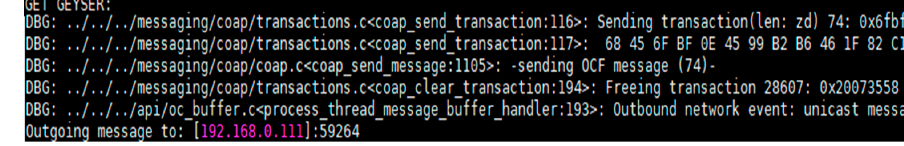
Figure 9. HAN server GET response .